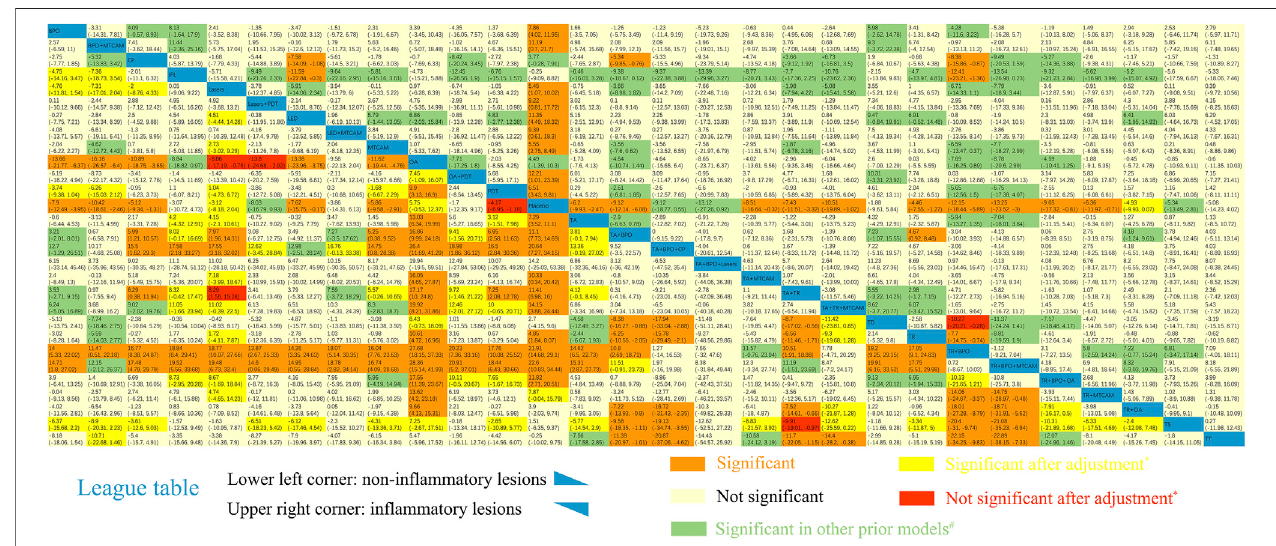
FIGURE 4 | League table of NMA estimations. Lower-left corner: Mean difference of nonin fl ammatory lesions count. Upper-right corner: Mean difference of in fl ammatory lesions count. *The results became signi fi cant after adjustment via metaregression. #The results became signi fi cant in other prior models. Comparisons should be read from up to right in the lower-left corner or from down to left in the upper-right corner.